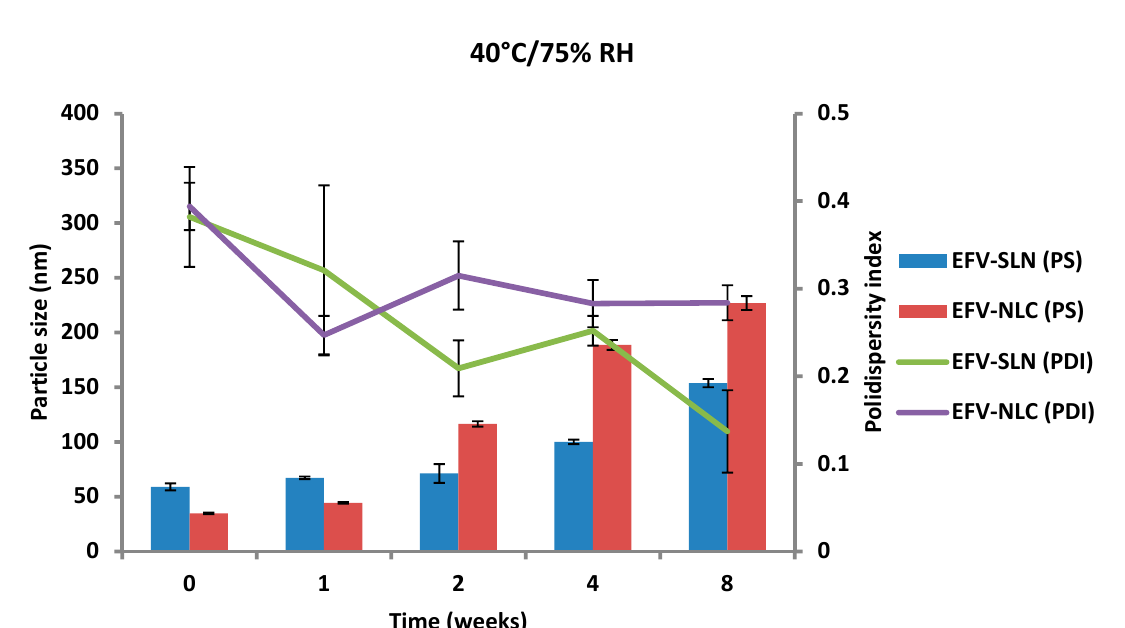
Figure 13. Particle size and size distribution of SLN and NLC following storage at 25 °C/60% RH .